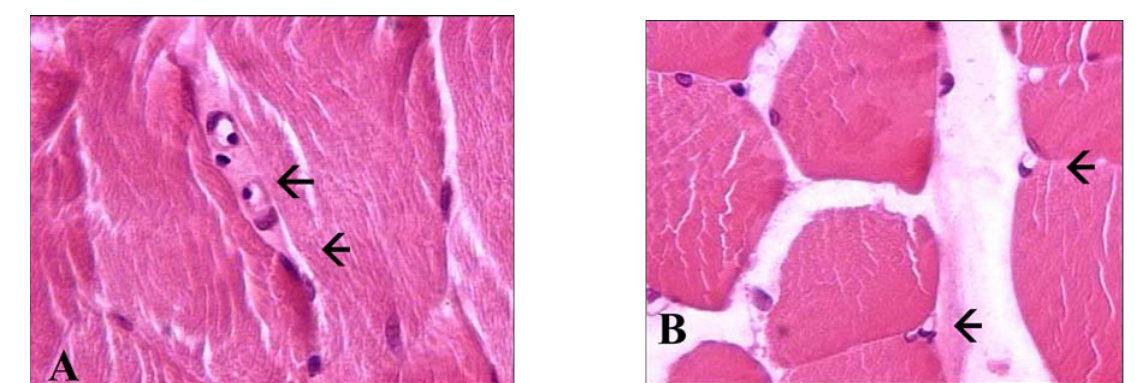
FIGURA 1 - Fotomicrografias do músculo vasto medial direito. A e B – Cortes transversais da porção mais proximal à oclusão da artéria femoral direita mostrando as células endoteliais dos capilares (setas) entre os feixes musculares. Hematoxilina e eosina – 4000x.